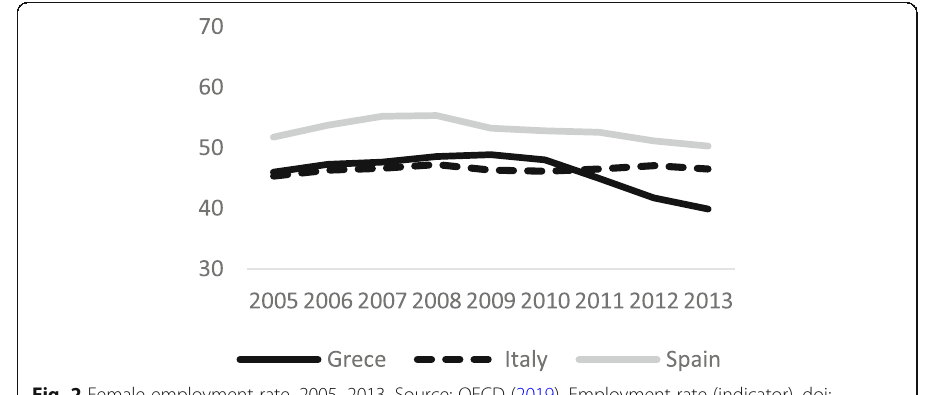
Fig. 2 Female employment rate, 2005 – 2013. Source: OECD (2019), Employment rate (indicator).